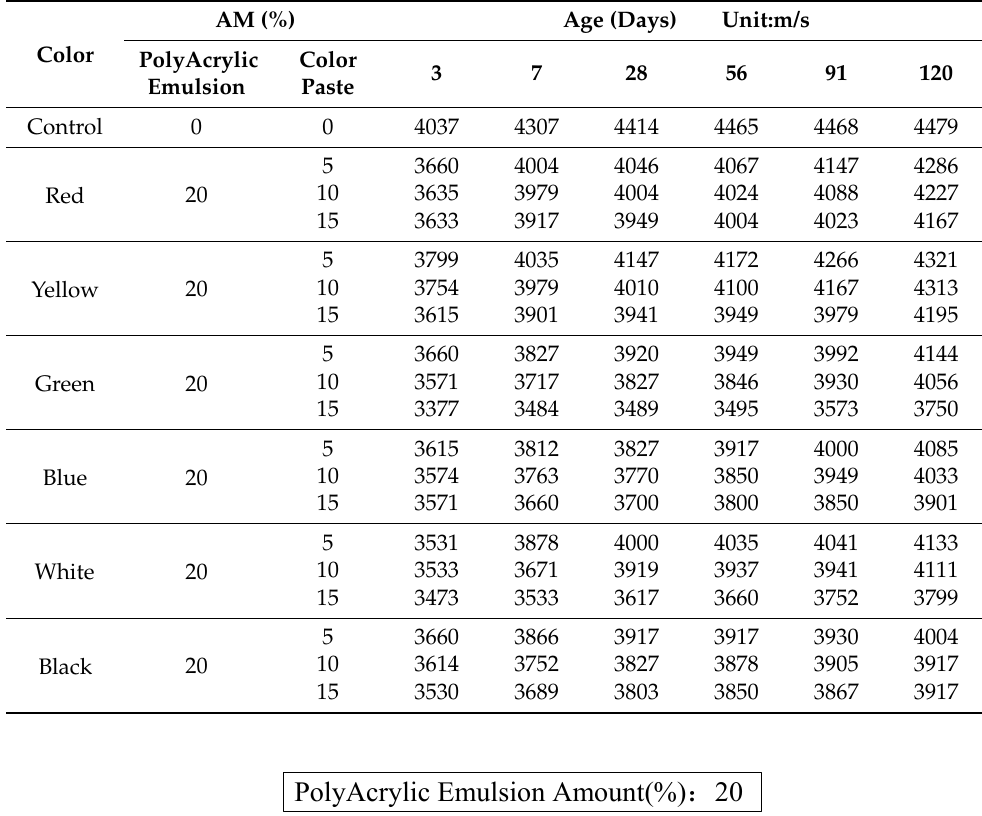
Table 5. UPV of mortar with different proportions of polyacrylic emulsion and inorganic color paste.